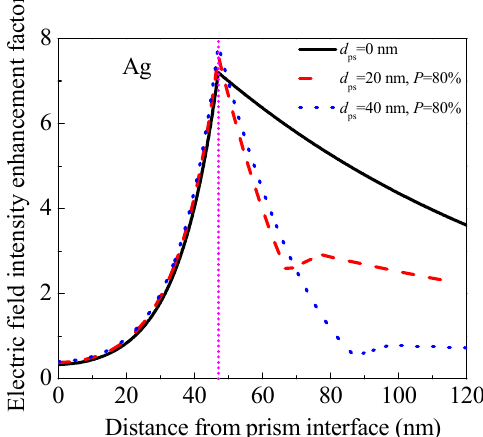
Figure 8. (Color online) Electric field intensity enhancement factor inside the SPR sensors in Figure 7.